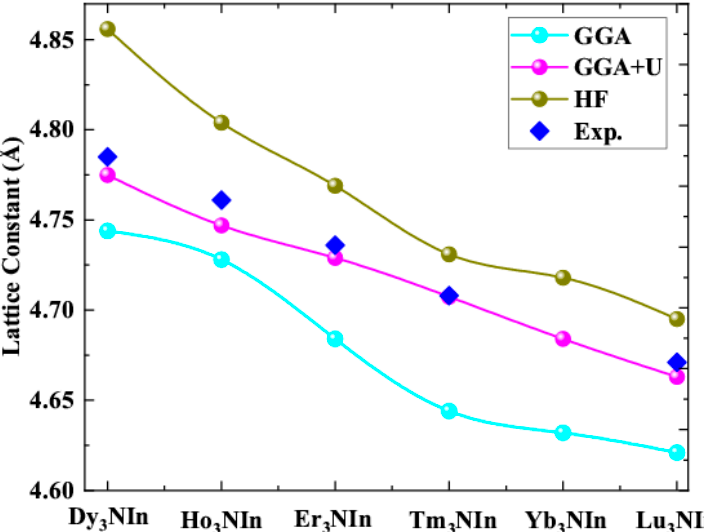
Figure 4. Comparison of calculated and experimental lattice constants of the rare earth nitrides Ln 3 NIn (Ln = Dy-Lu) anti-Perovskite. Ln 3 NIn (Ln = Dy-Lu)